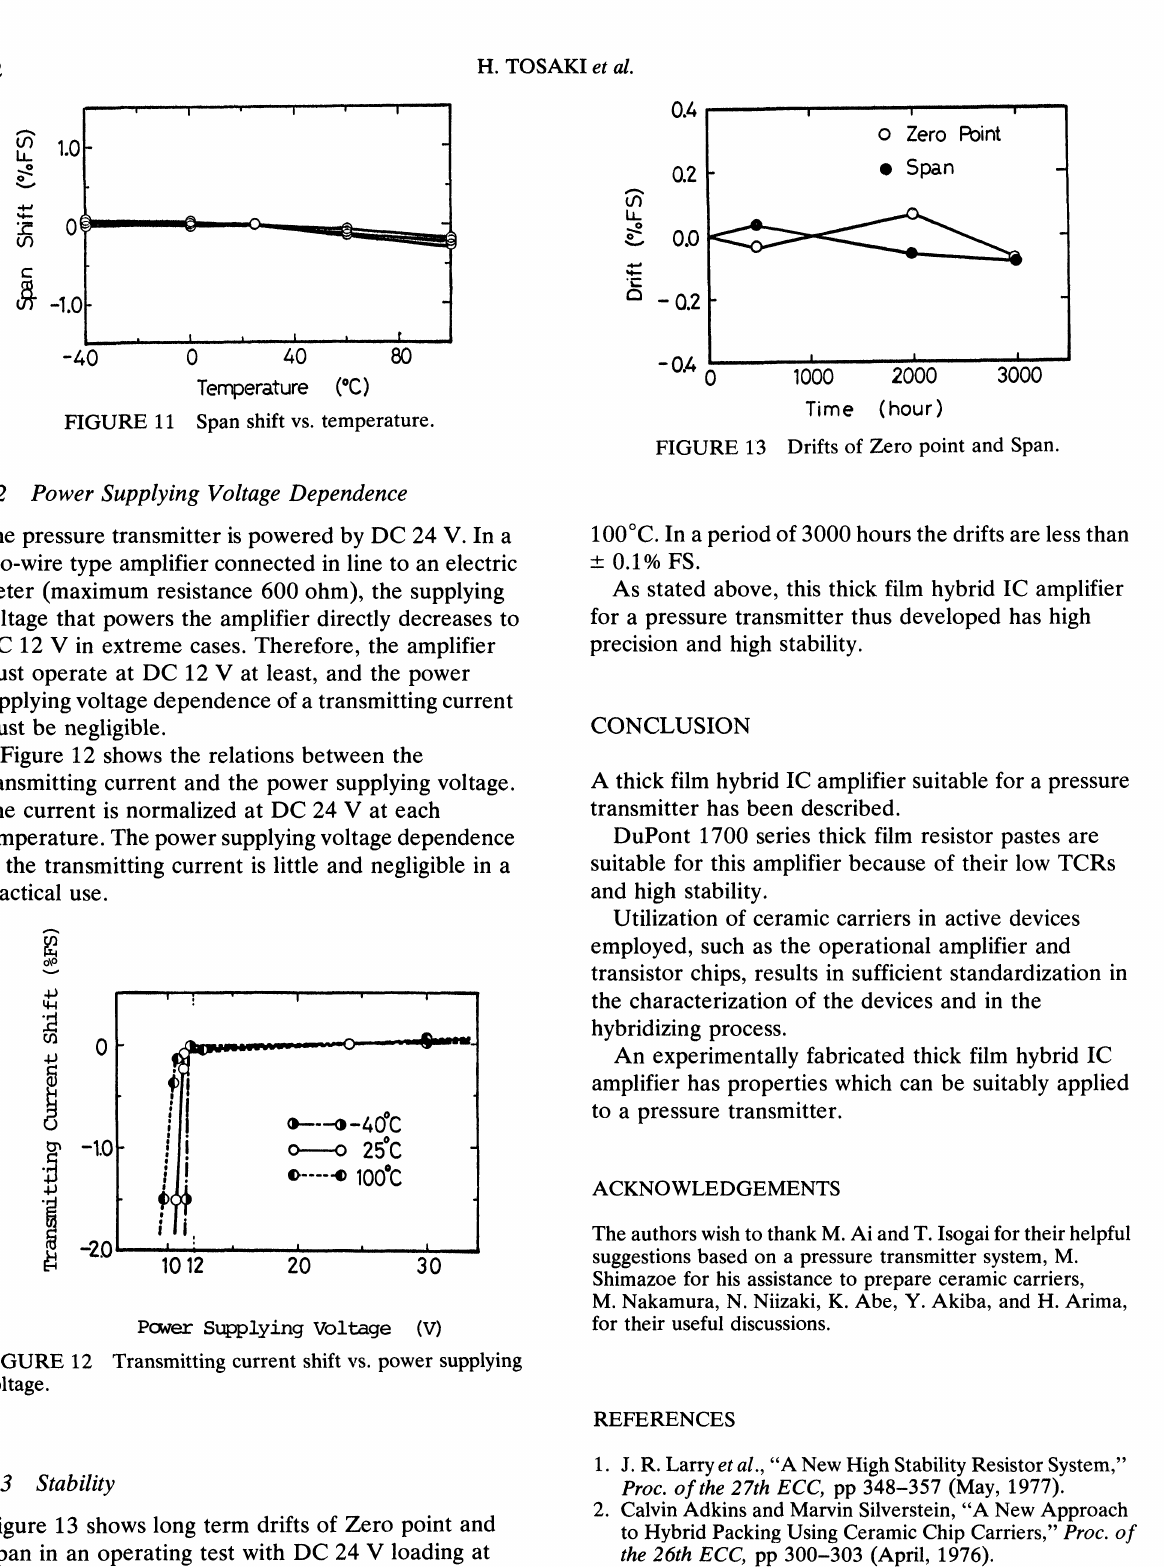
FIGURE 12 Transmitting current shift vs. power supplying